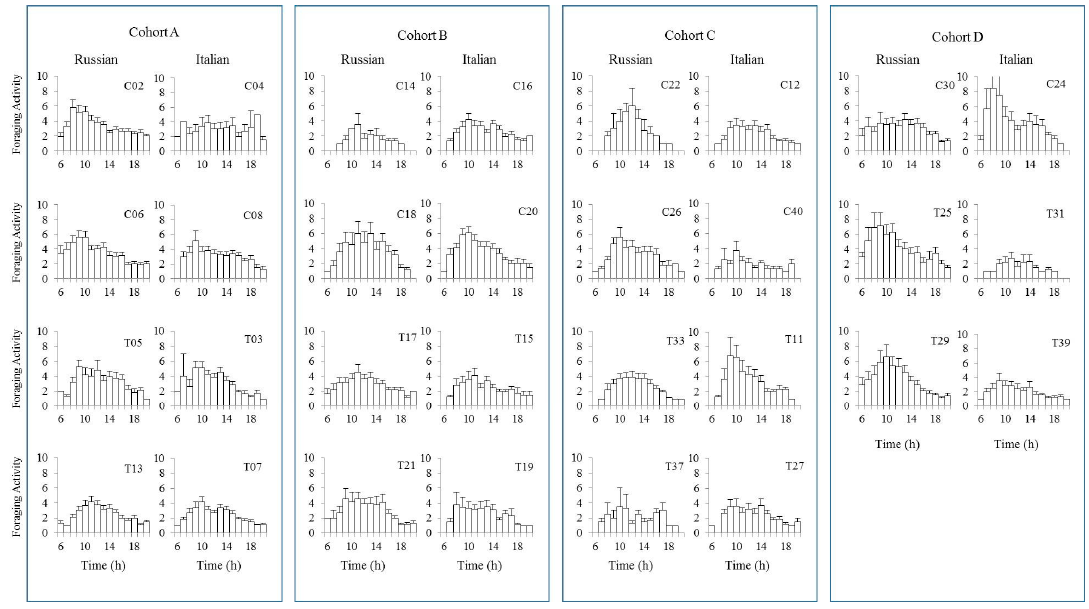
Figure 3. Daily flight patterns performed by Russian and Italian honey bee colonies throughout the experiment. Each bar represents an hour of the day starting from 6:00 a.m. (sunrise) to 8:00 p.m. (sunset).